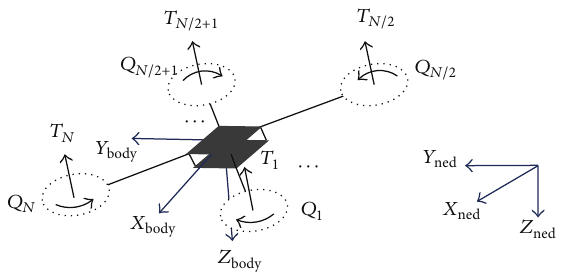
Figure 1: Free body diagram of